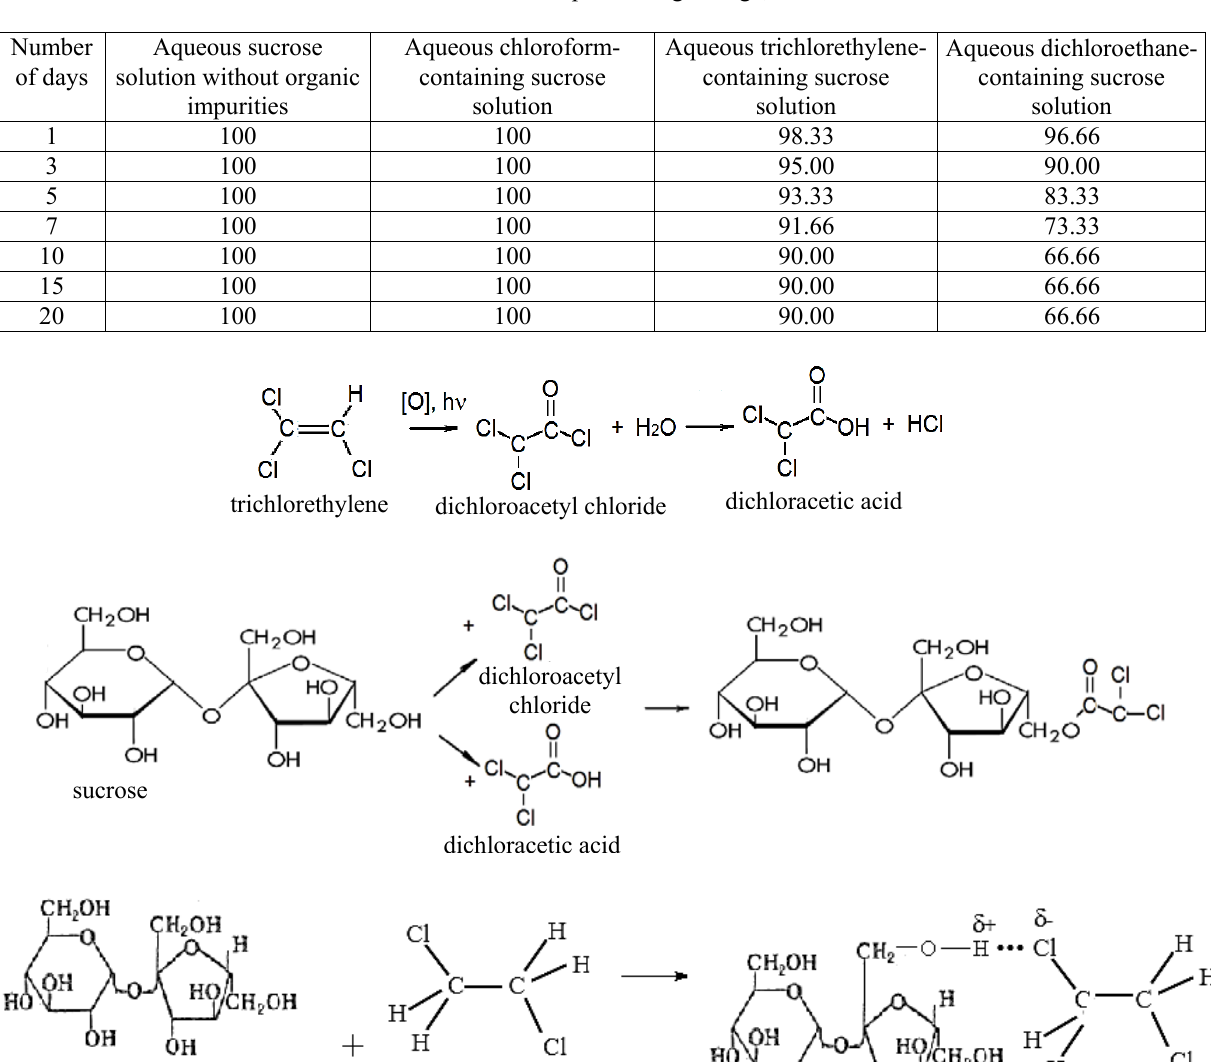
1 Table 2. Residual content of sucrose in the studied samples during storage, %